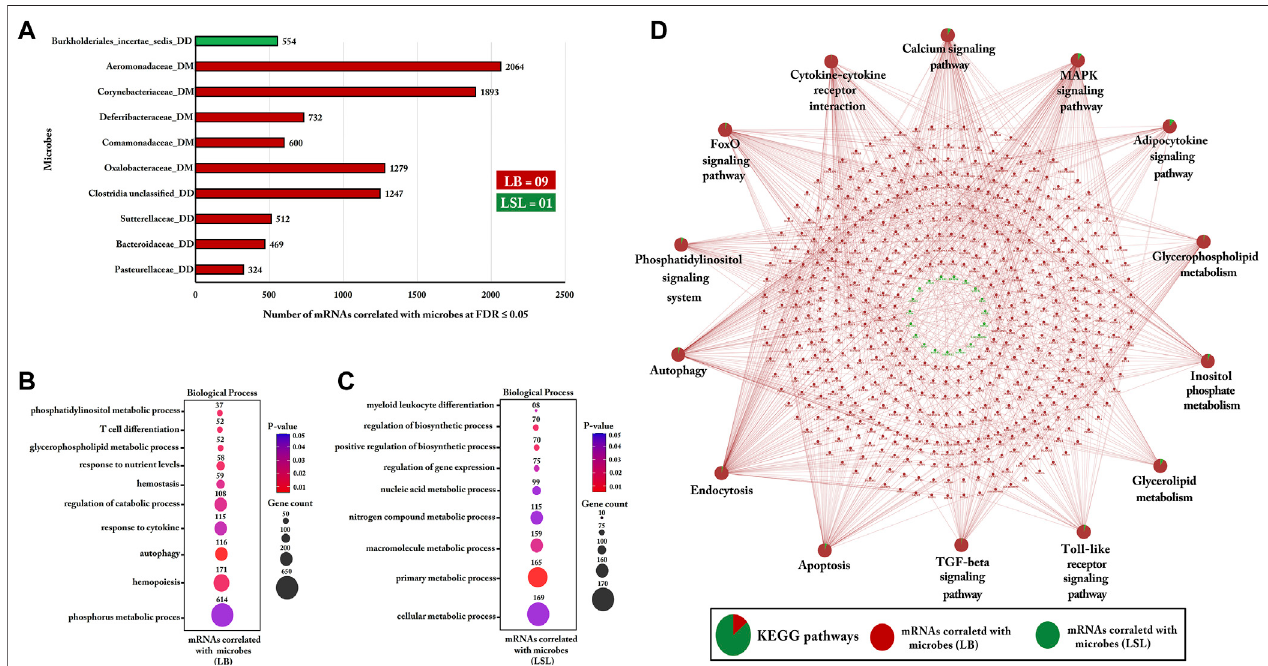
FIGURE 11 | Gene Ontology and KEGG pathways enrichment analysis of mRNAs correlated with duodenal microbiota within LB and LSL. (A) The bar chart indicates the number of mRNAs correlated with microbes at FDR ≤ 5% within LB and LSL (r ≥ 0.5). The green bar shows more abundant microbes in LSL, while the red bar depicts more abundant microbes in LB. (B) The transcripts correlated with microbes in LB were subject to DAVID (version 6.8) for Gene Ontology (biological processes) enrichment analysis. (C) Gene Ontology (biological processes) enrichment analysis of transcripts correlated with microbes in LSL. The dot size represents the number of transcripts involved in each biological process, while the dot ’ s color indicates the p -value. (D) KEGG pathway enrichment analysis of mRNAs correlatedwithmicrobeswithinLBandLSL.Thepiechartsindicatethestrain-speci fi cproportionsofmRNAscorrelatedwithmicrobiotatotheKEGGpathways.Thered ellipse shows mRNAs correlated with microbes in LB, and the green ellipse depicts mRNAs correlated with microbes in LSL. KEGG pathways and biologicalprocesses with p ≤ 0.05 were considered signi fi cant.